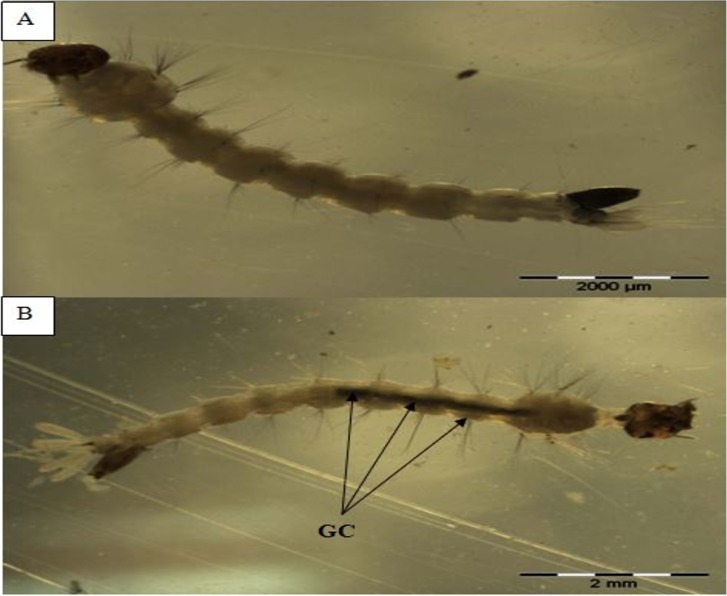
Morphological midgut content induced by Azolla pinnata plant extract from maceration and soxhlet extraction method in larvae of Ae. Albopictus.(A) Control test for midgut content view in early 4th instar larvae of Ae. Albopictus (B) A. pinnata crude extract for midgut content view in larvae of Ae. Albopictus Note: Arrows indicating the plant extracts (greenish color), GC: gut content (after 24hours).